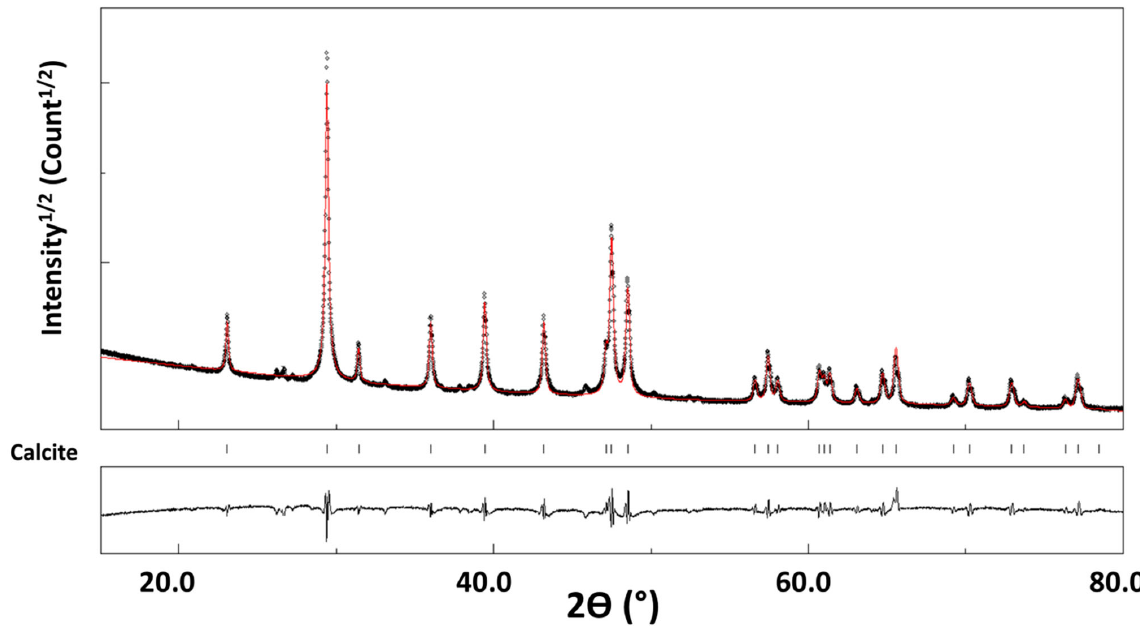
Figure 7. X ‐ ray diffraction pattern of scallop powder refined with the MAUD software. Figure 7. X-ray diffraction pattern of scallop powder refined with the MAUD software. Table 6. Refined values of lattice parameters, unit cell volume, average diameter, microstrain < ε 2> Table 7. Mortar composition and permeability after 28 1/2. Standard deviations are indicated in parenthesis on the last digit.